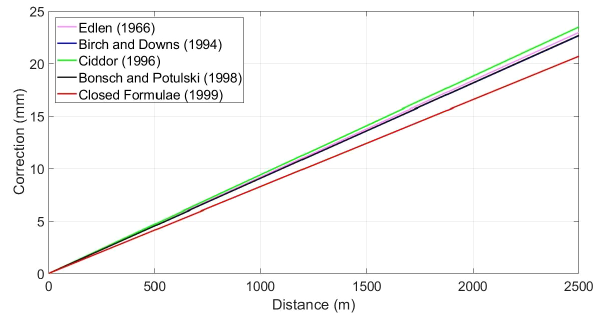
Figure 9. Correction vs. measured distance